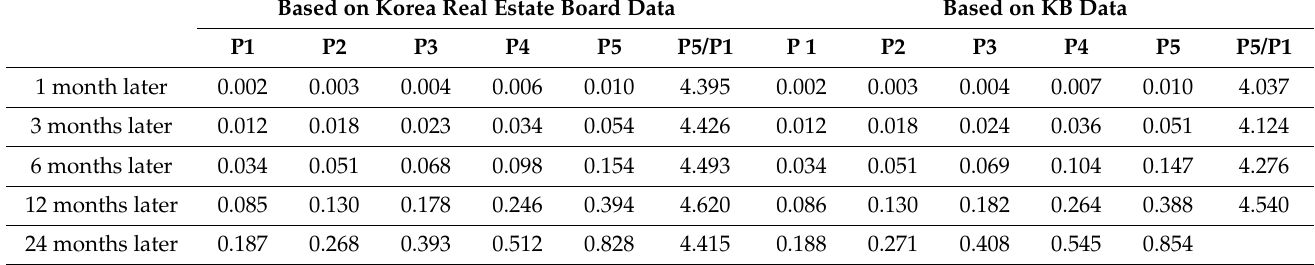
Table 4. Analysis of the Cumulative Impulse Response Function of Time Variable at the Time of Interest Rate